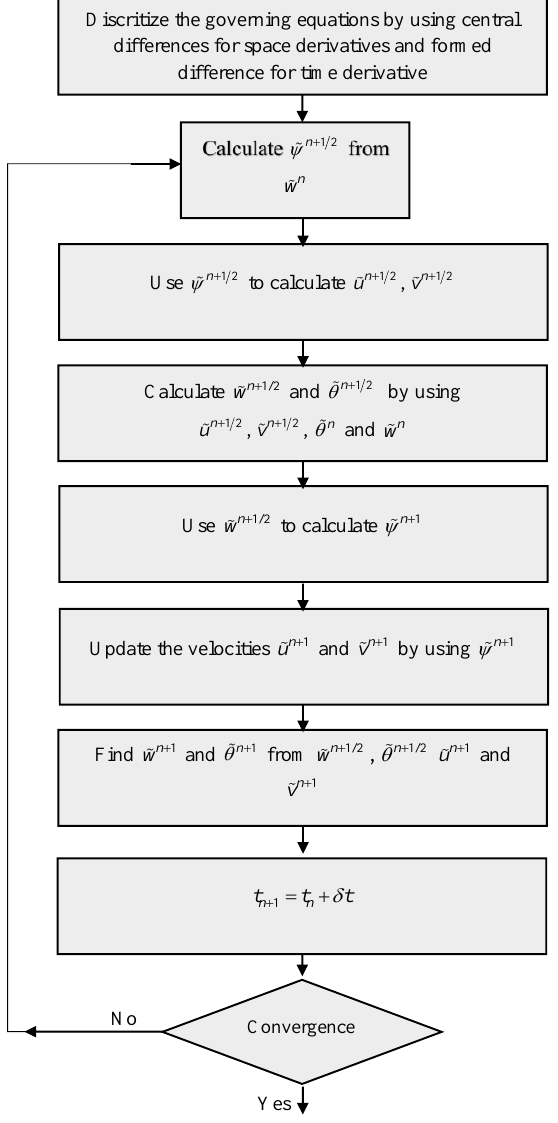
Figure 2. Flow chart diagram for the Pseudo Transient